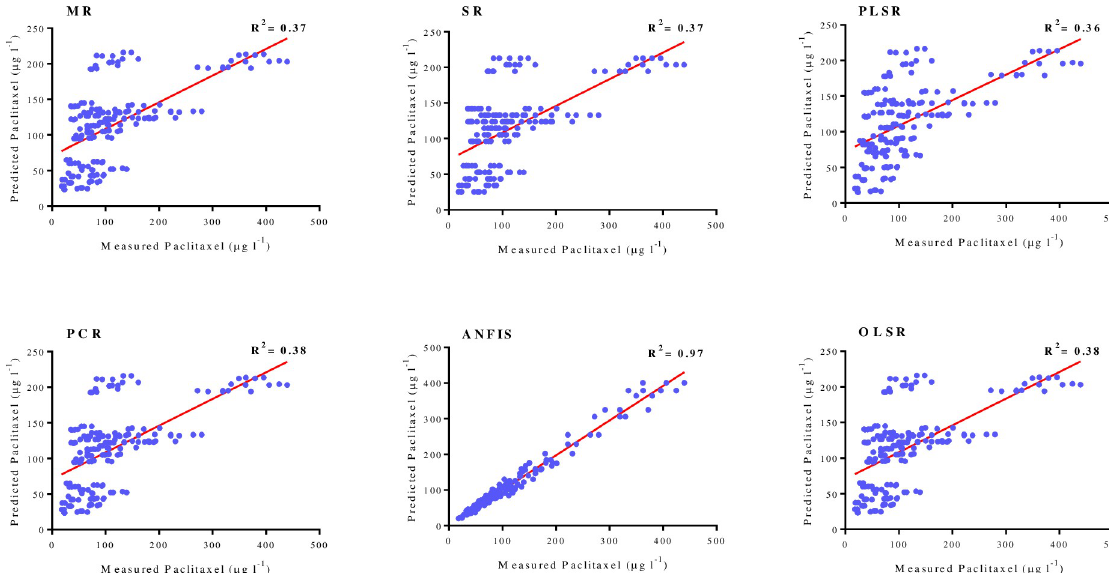
Fig 6. Scatter plot of actual data against predicted values of paclitaxel biosynthesis in Corylus avellana cell cultures exposed with different concentration of fungal cell wall (CW), either individually or combined treatment with 50 mM methyl- β -cyclodextrin (MBCD), using adaptive neuro-fuzzy inference system (ANFIS), multiple liner regression (MLR) stepwise regression (SR), ordinary least squares regression (OLSR), principal component regression (PCR) and partial least squares regression (PLSR) models in training subset. The solid line shows fitted simple regression line on scatter